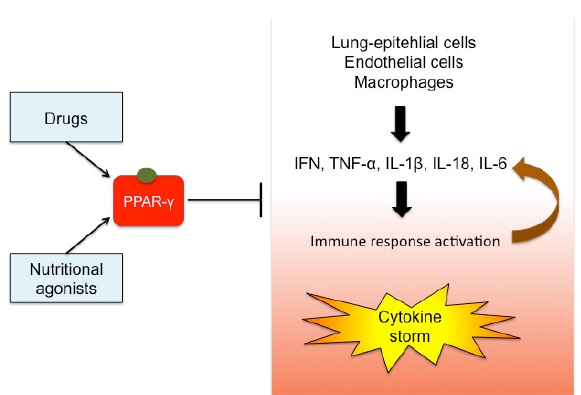
Figure 3. E ff ects of PPAR- γ activation on cytokine storm. The stimulation of PPAR- γ by drugs or foods can exert a regulatory role on the cytokine storm typical of virus infections. Pro-inflammatory cytokines (e.g., IFN, TNF- α , IL-1 β ) are released by lung-epithelial cells, endothelial cells, and immune cells, inducing the immune system response. This mechanism recruits chemokines and other cytokines, in a vicious circle out of control. PPAR- γ acts on the transcription of the upstream inflammatory genes, thus preventing the cytokine over-production and becoming an attractive target for immunomodulatory therapies in the case of viral